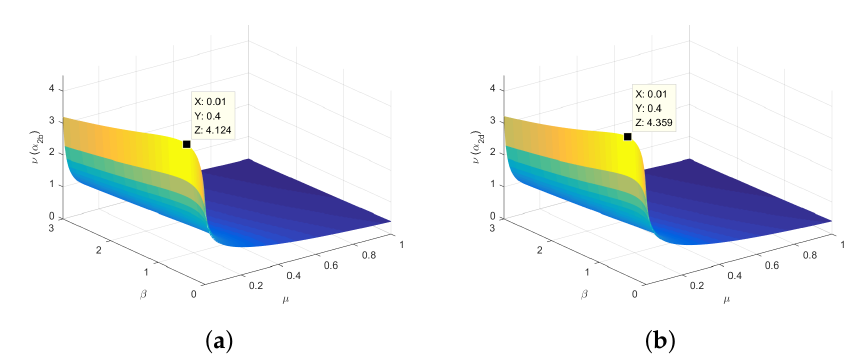
Figure 4. The relationship of ( µ , β , ν ( α 2 )) : ( a ) ( µ , β , ν ( α 2 b )) space; ( b ) ( µ , β , ν ( α 2 d )) space.